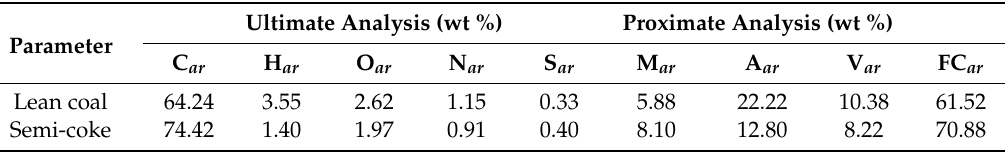
Table 1. The ultimate and proximate analysis of the